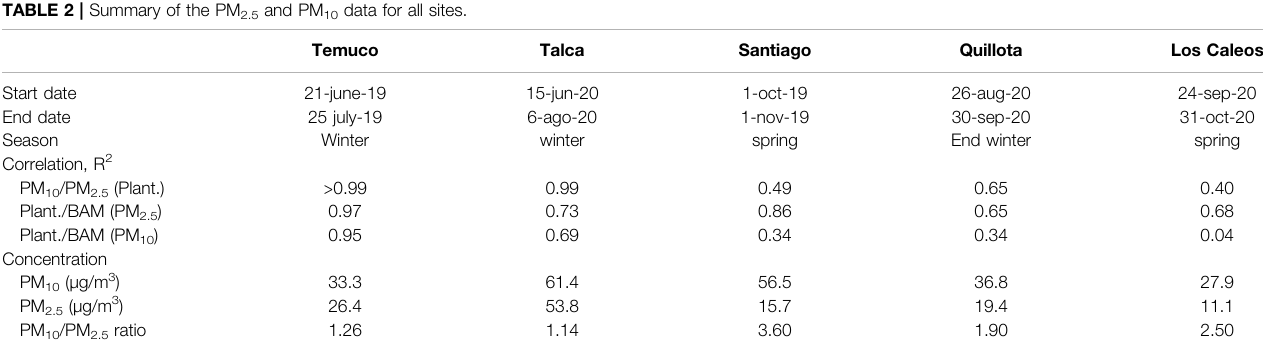
TABLE 2 | Summary of the PM 2.5 and PM 10 data for all sites. Temuco Talca Santiago Quillota Los